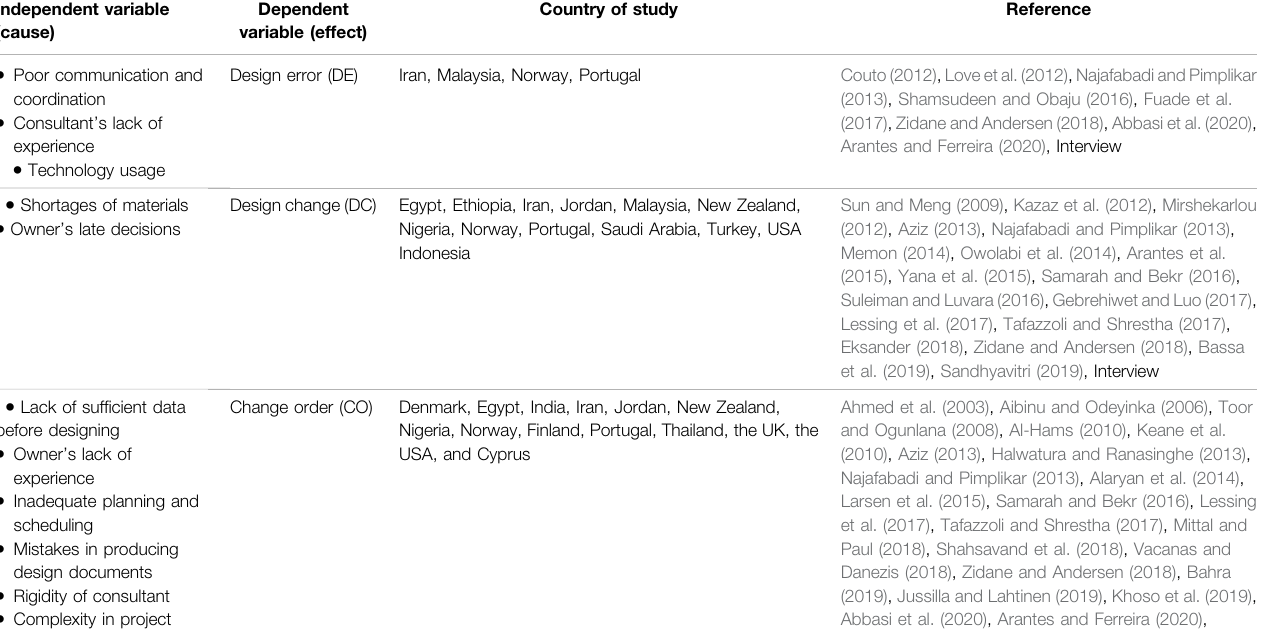
TABLE 2 | Key factors (dependent variables) and independent variables affecting construction